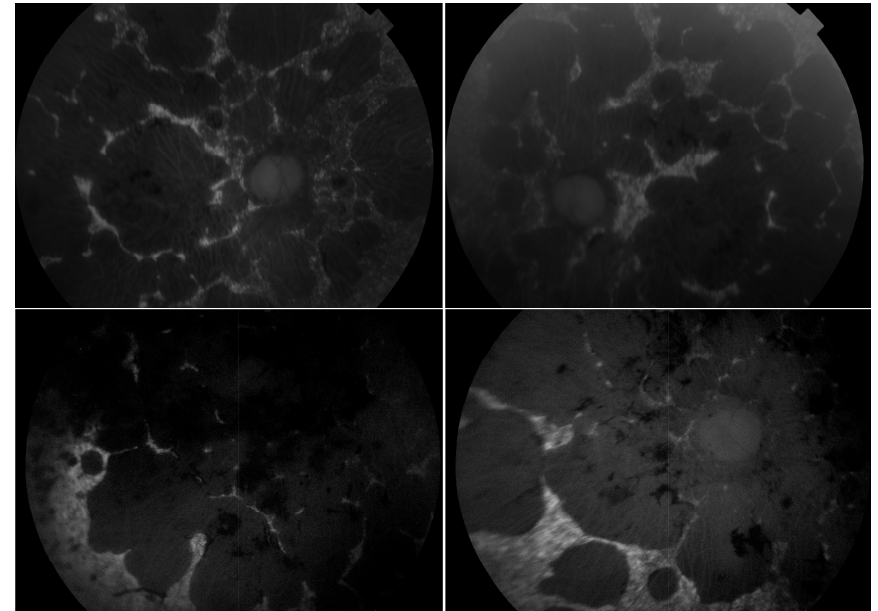
Figure 4. Collage of fundus images of a patient initially presenting with a Stargardt phenotype that progressed to phenotype suggestive of retinitis pigmentosa. Extensive pigmentation can be seen at both maculae and also in the periphery of both eyes ( left —right eye, right —left eye). There are also distinct punched-out areas in the pigment epithelium bilaterally. Genes 2020 , 11 , 105